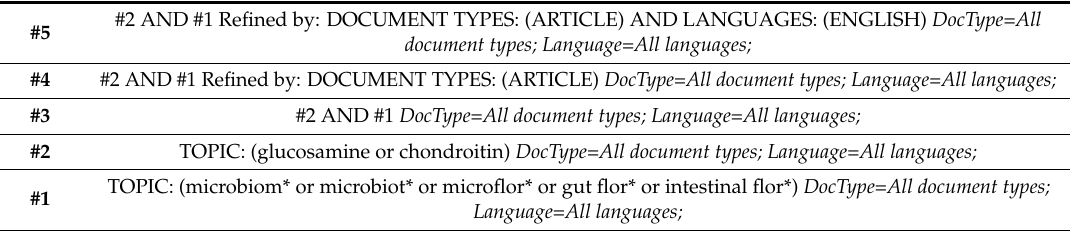
Table A1. Web of Science.